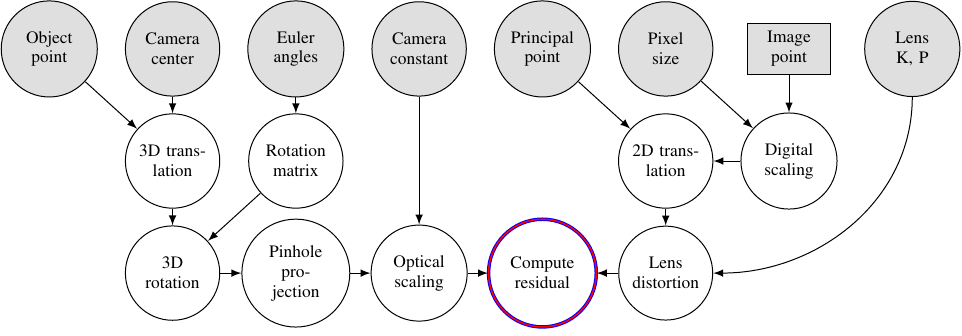
Figure 2: The computational chain implemented in DBAT (B¨orlin and Grussenmeyer, 2013). In the photogrammetric formulation, the optical scaling in the camera results in image coordinates expressed in physical units, e.g. mm. The image coordinates are scaled from pixels to mm before the Brown (1971) polynomials are used to ”correct” the measured image coordinates for lens distortion. The residual (thick circle) is computed as the difference between the projected ideal point and the corrected point.